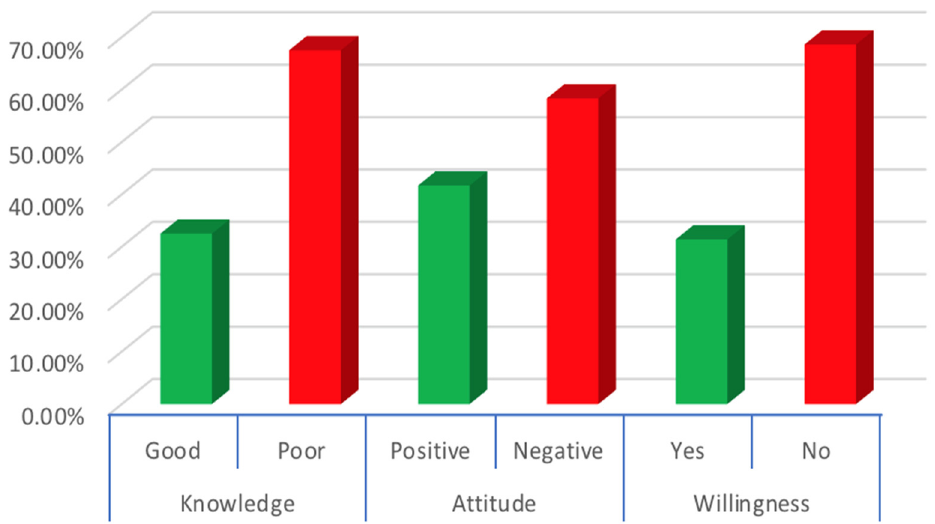
Figure 1. Percentage distributions of knowledge (good and poor), attitude (good and poor), and vaccine willingness (yes and no) for monkeypox among Turkish physicians.